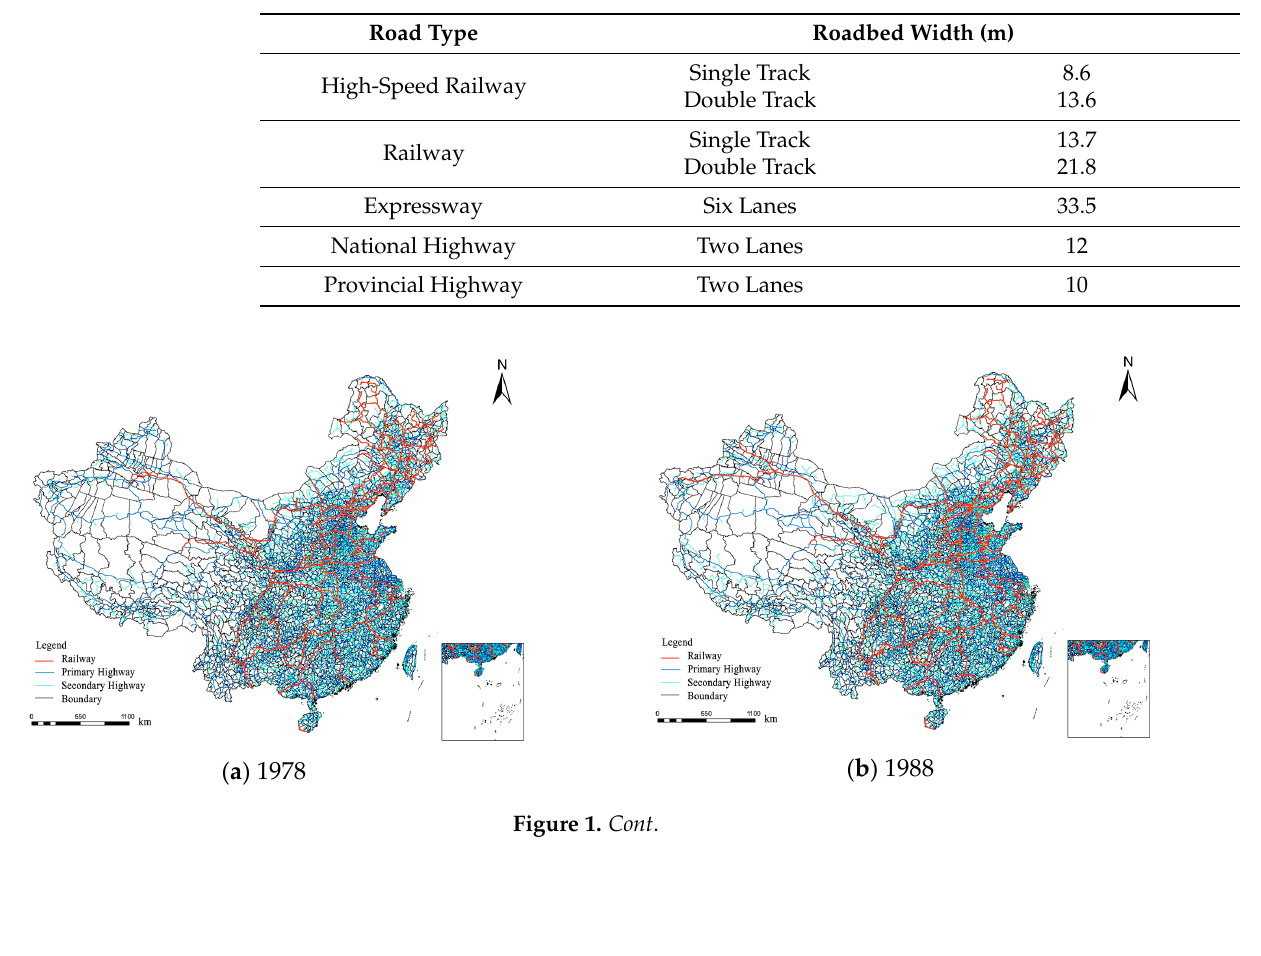
Table 1. Standard width of roadbed for different types of roads.